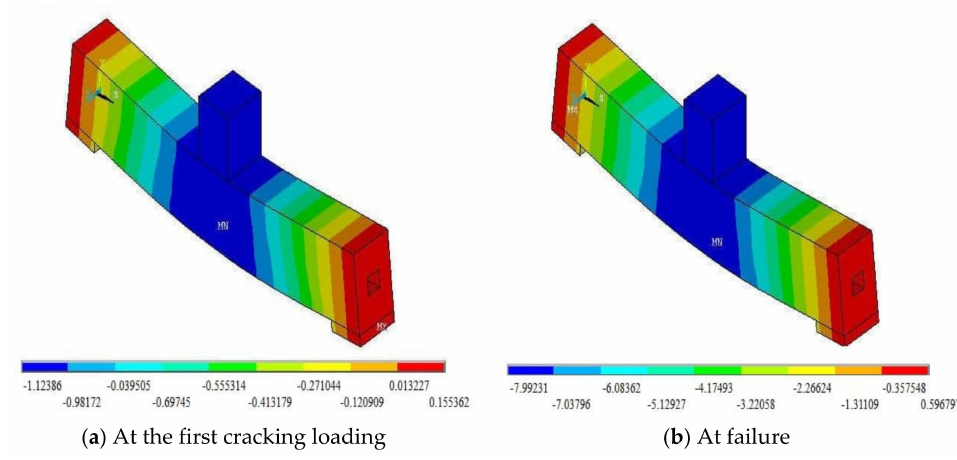
Figure 12. 3D deflection contours of beam model B4 at different loading stages.